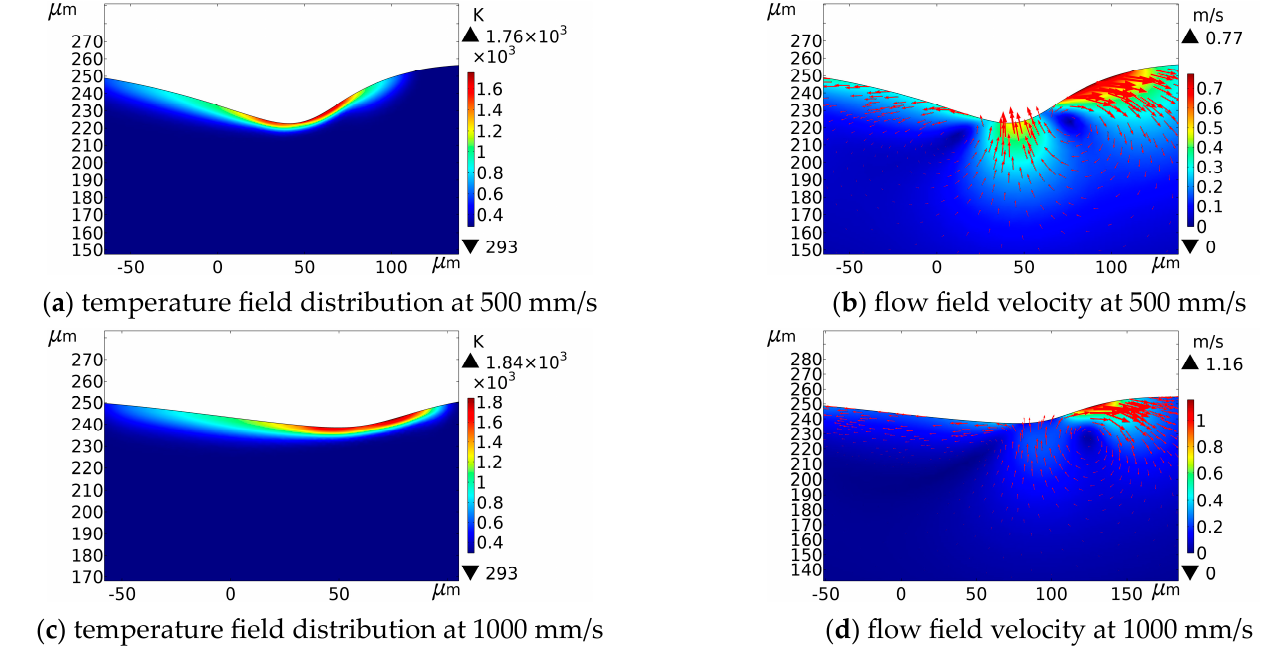
Figure 8. Temperature field distribution and flow field velocity at different scanning speeds (Average power = 8 W, pulse width = 40 ns, frequency = 150 kHz).